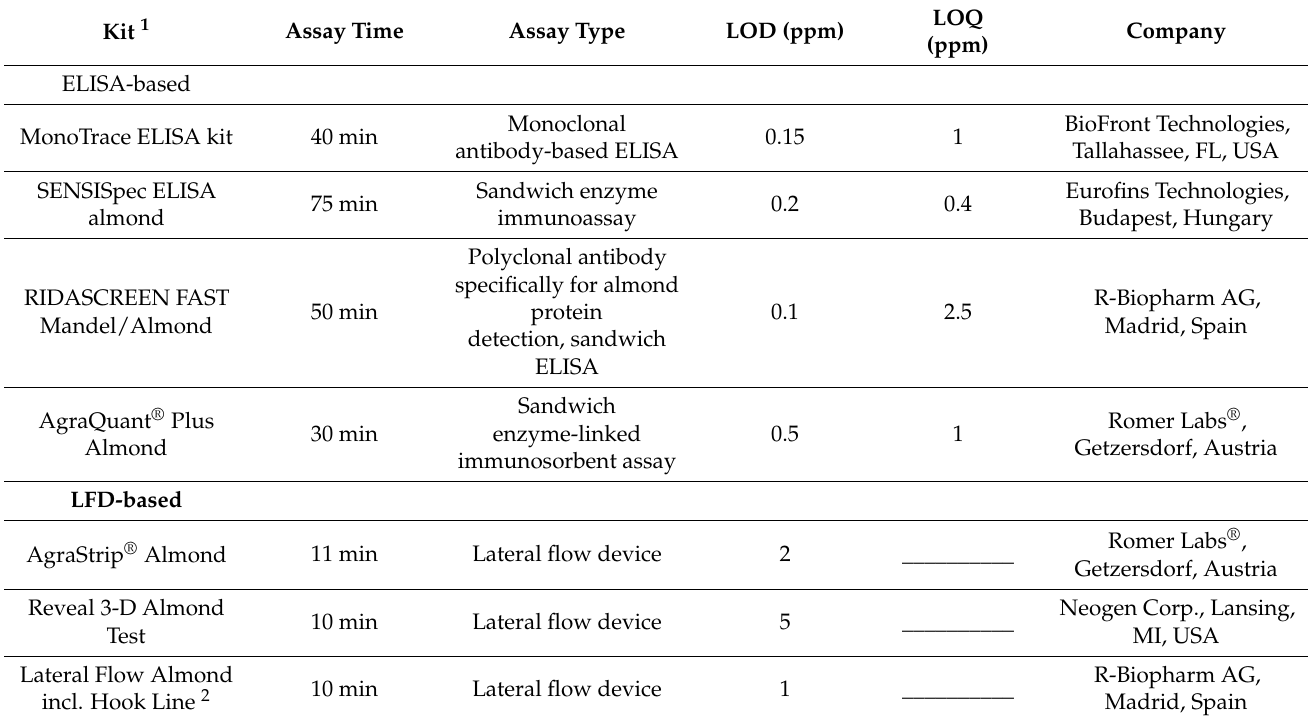
Table 3. Example of commercial immunological kits for almond detection and/or quantification and their main characteris- tics: time for results including extraction times, assay type, limit of detection (LOD), limit of quantification (LOQ) and their